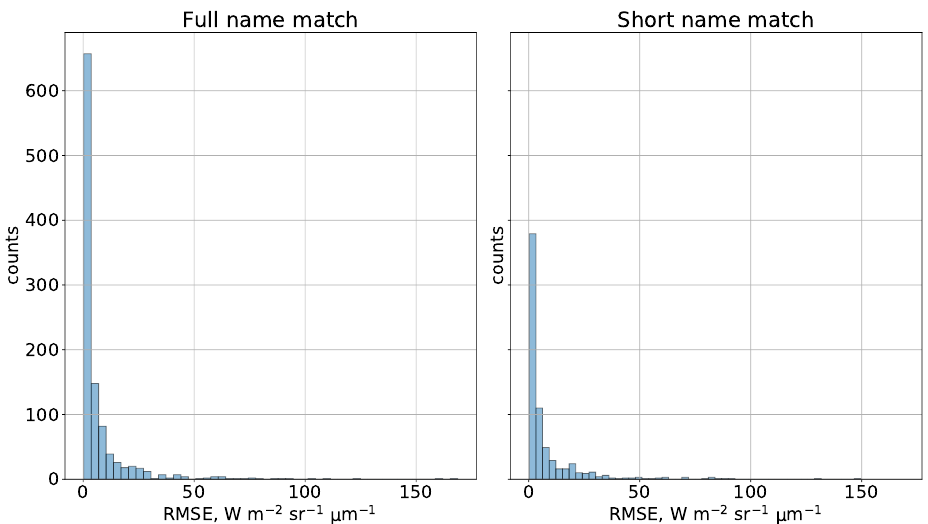
Figure 4. Root mean squared error (RMSE) between GEE and Copernicus OLCI products with the same